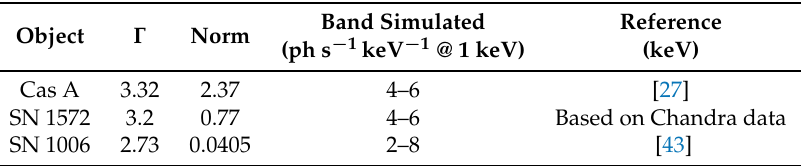
Table 2. Spectral power-law parameters used for the